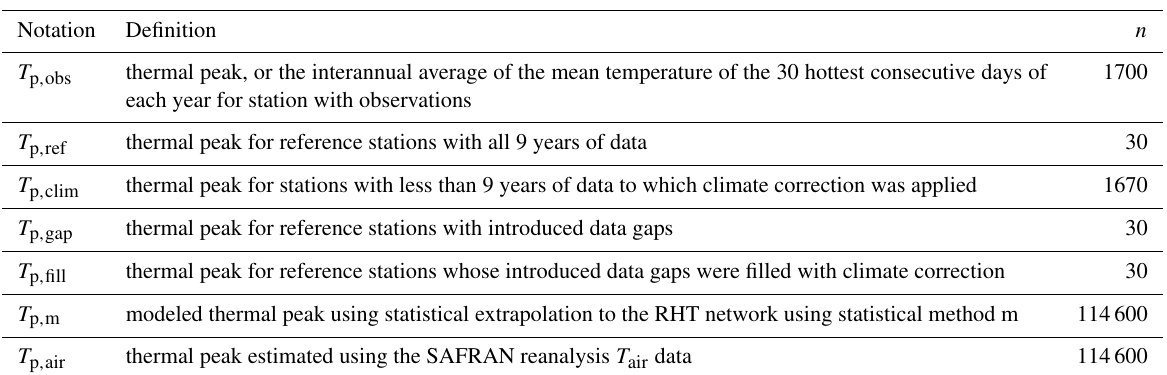
Figure 1. Data availability for each temperature station used in this study. (a) Map of stream temperature stations in France with RHT network shown for all reaches of Strahler order > 4. (b) Heatmap of data availability by year ( x axis) and station ( y axis) with the total stations per year listed at the top of each column. Sites are colored by the number of years with observations. (c) Distributions of drainage area for RHT reaches (blue) and of thermal stations (black). Table 2. List of thermal peak terminology with the count of sites ( n ) used in their